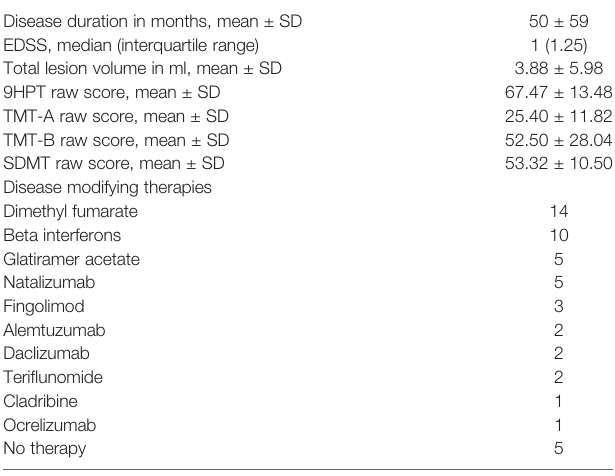
TABLE 1 | Overview of patients ’ clinical characteristics. Disease duration in months, mean ±